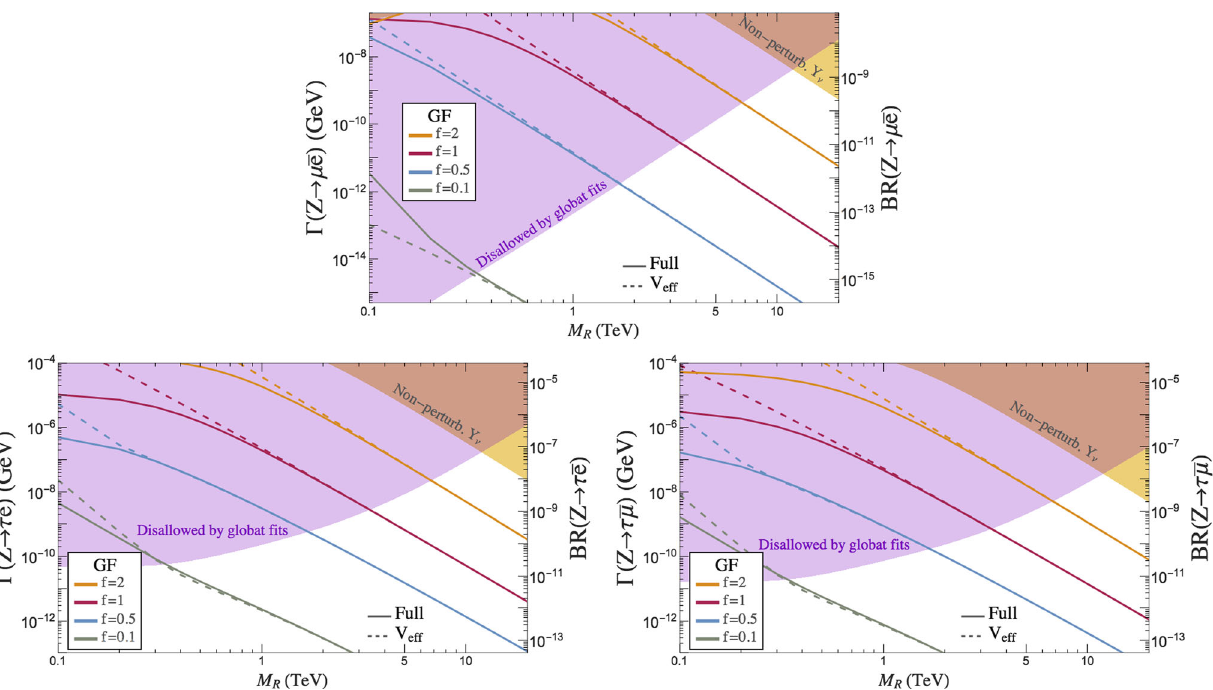
Fig. 7 Predictions for Z → μ ¯ e (top), Z → τ ¯ e (left) and Z → τ ¯ μ (right) using the effective vertex computed with the MIA (dashed lines) and the full results in the mass basis (solid lines) for Y GF ν in Eq. (40)